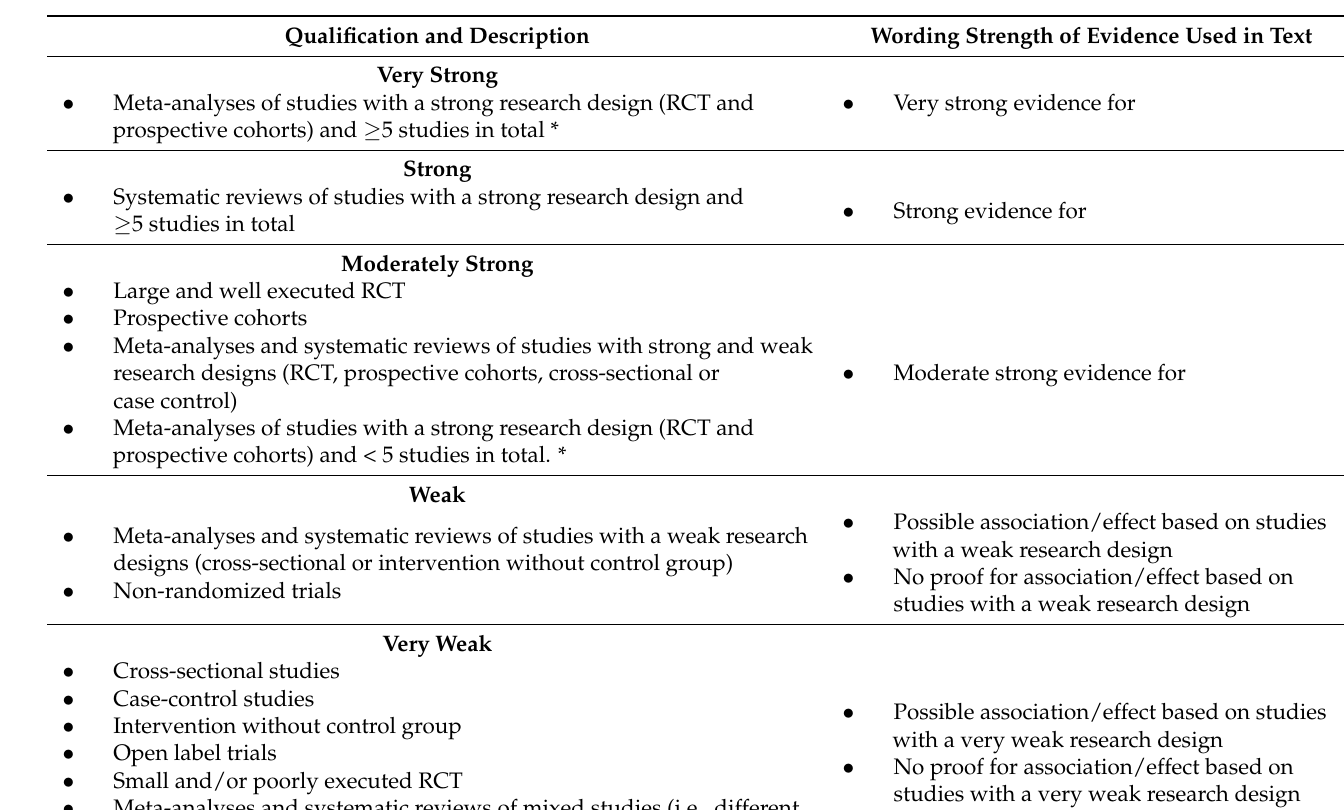
Table 1. Criteria for strength of evidence and wording used in text, translated and adapted from